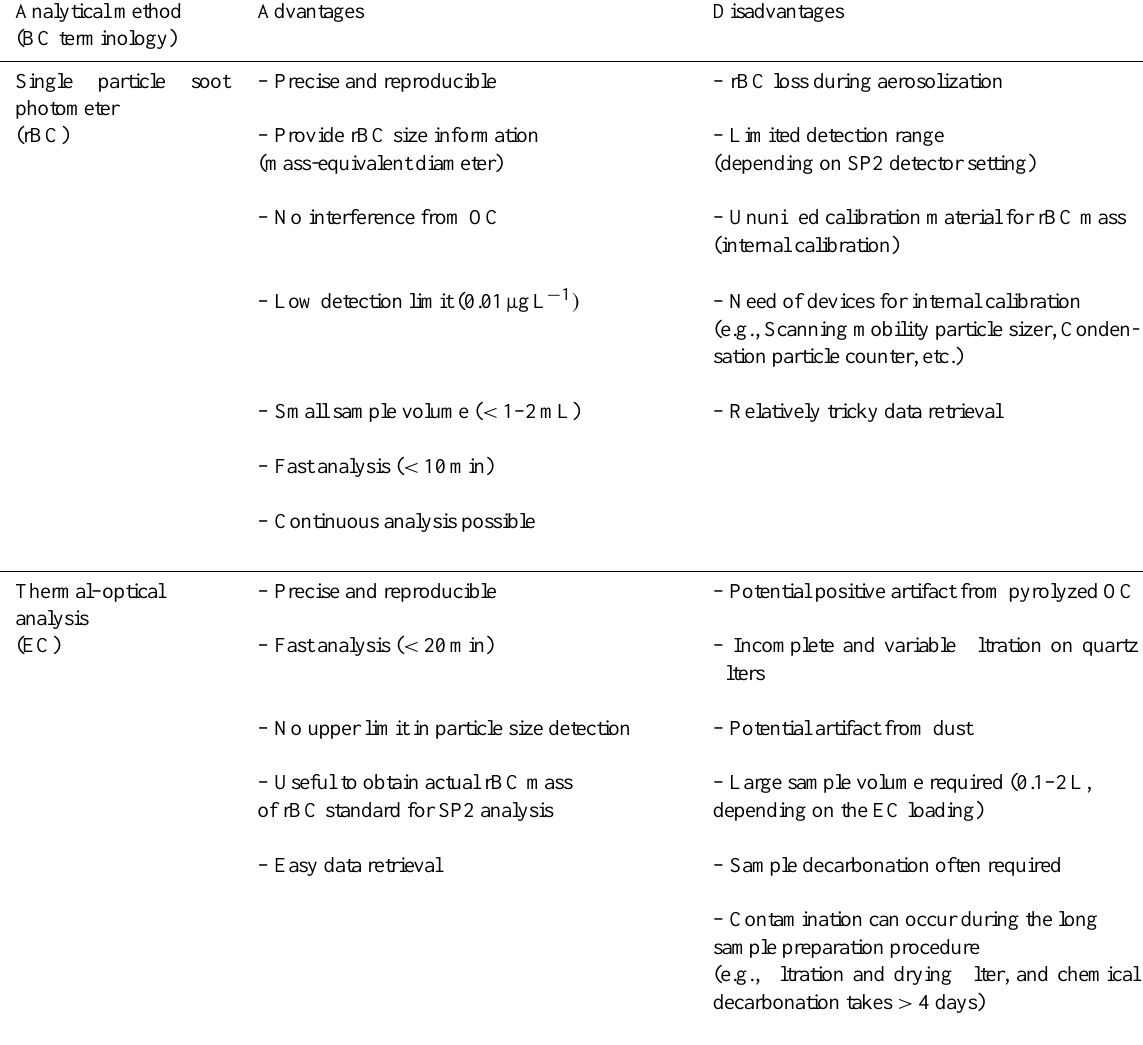
Table 3. Evaluation of advantages and disadvantages of the SP2-based method and the thermal–optical method. Analytical